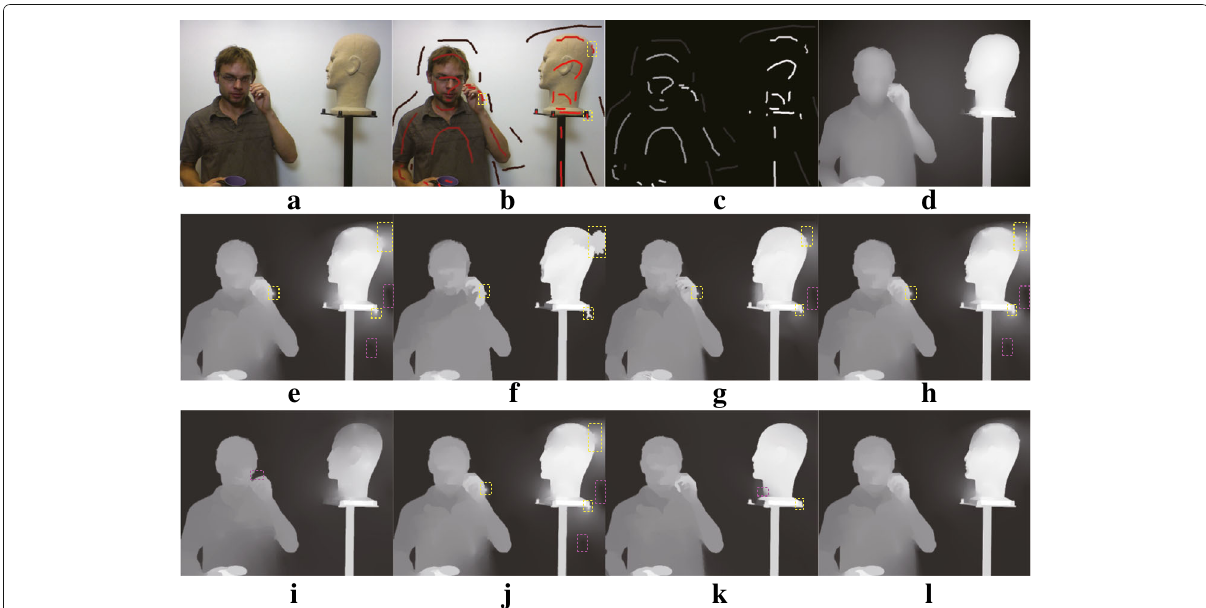
Fig. 8 Results of RGBZ_05 with cross-boundary input. a Input image. b User-labeled image. c Sparse depth. d Groundtruth depth. e Depth of RW. f Depth of HGR. g Depth of NRW. h Depth of OPT. i Depth of OCP. j Depth of SDF. k Depth of (cid:2) 1 . l Depth of the proposed method. Please zoom in to see details